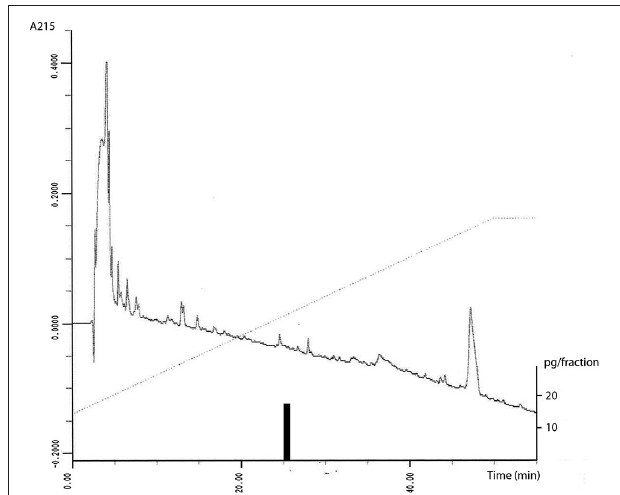
FIGURE 1 | The figure depicts OXA concentrations in HPLC fractions of 4 ml human plasma extracted with Sep-Pak C 18 Cartridges. Elution from 0 to 60% of acetonitrile in 0.1% trifluoroacetic acid is shown by a dotted line with flow-rate 1 ml/min. Only fraction number 26 contained (1 min fraction) 17 pg immunoreactive OXA (right vertical axis is added to show the pg/fraction and a black bar to indicate the amount of OXA).